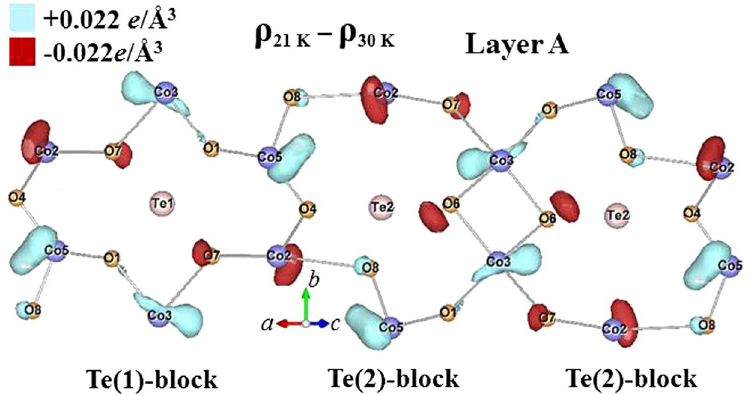
Figure 14. Contour map of the electronic charge density in Layer A that develops upon cooling from 30 K to 21 K, as obtained from the x-ray diffraction data. The regions marked by contours for a difference ECD of + 0.022 e /Å 3 are marked by light (turquoise) shading, while those of − 0.022 e /Å 3 are marked in dark (red)